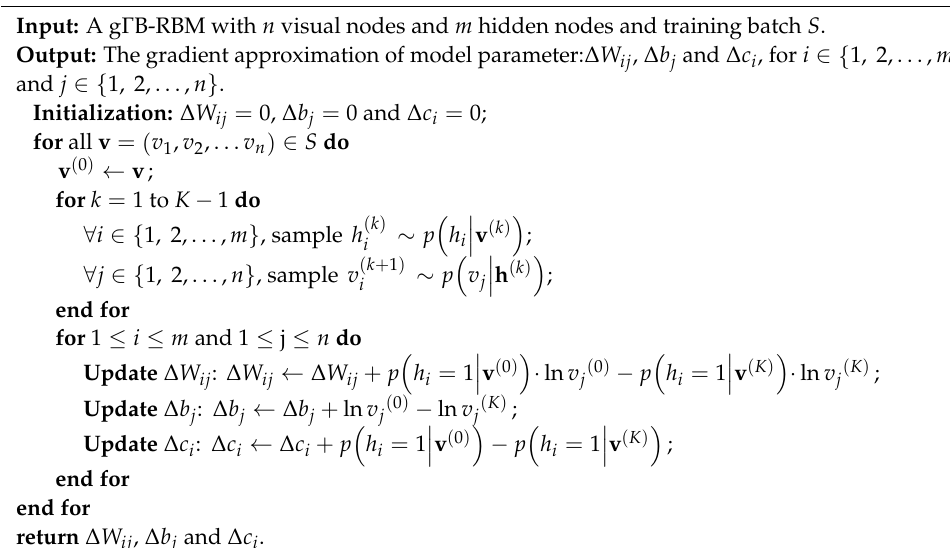
Algorithm 1. The g Γ B-RBM update for a mini-batch of size N s